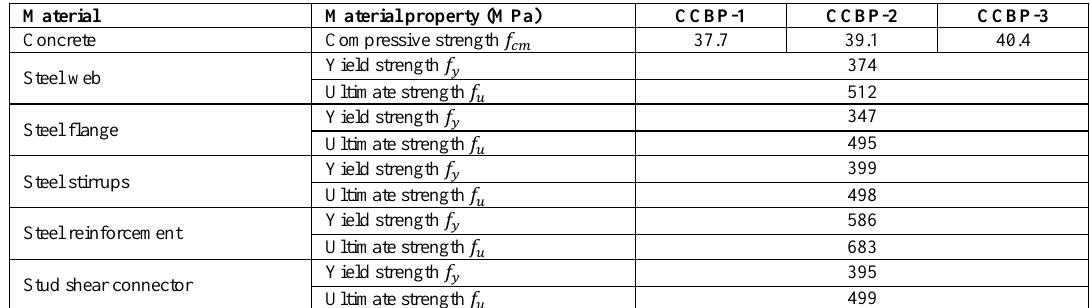
Table 2. Material properties of the composite beam curved in plan